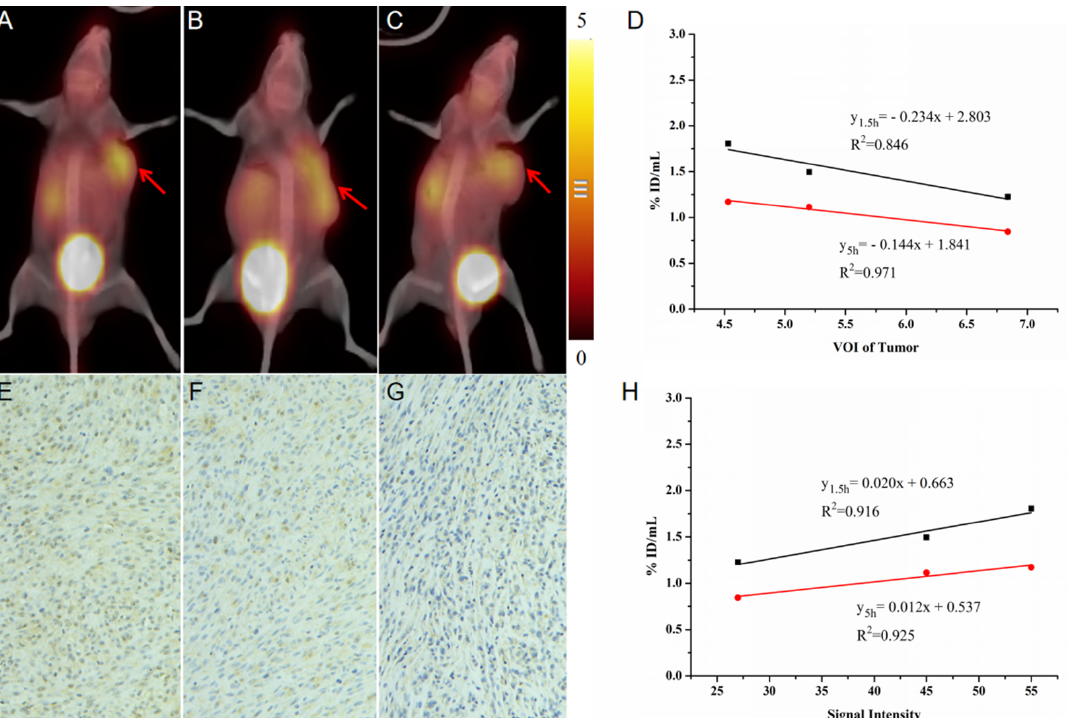
Figure 6. The correlation between 99m Tc-HYNIC-FAPI-04 SPECT and tumor progression, including tumor volume and FAP expression quantified by signal intensity of immunohistochemical (IHC). The volume progression of tumor and corresponding FAP expression in IHC ( A – G ), and correlation analysis result ( D ). Correlation between tracer uptake on 99m Tc-HYNIC-FAPI-04 SPECT and FAP expression ( H ). The red arrow pointed to FAP-positive tumors.